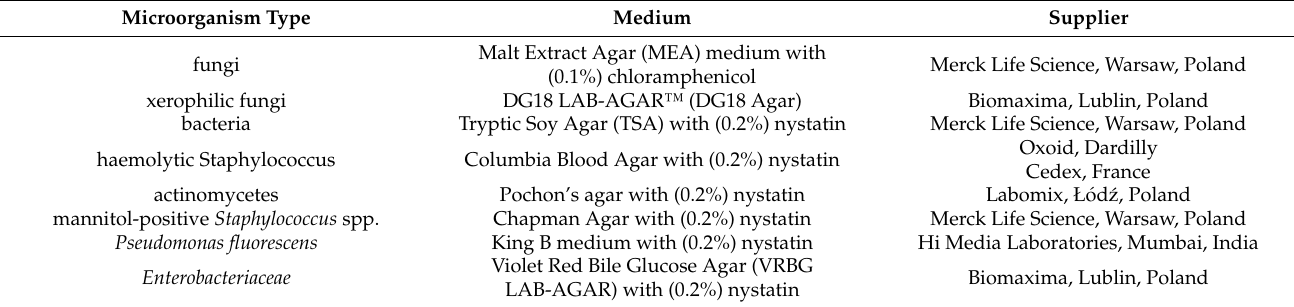
Table 2. Media used for microbiological contamination of air